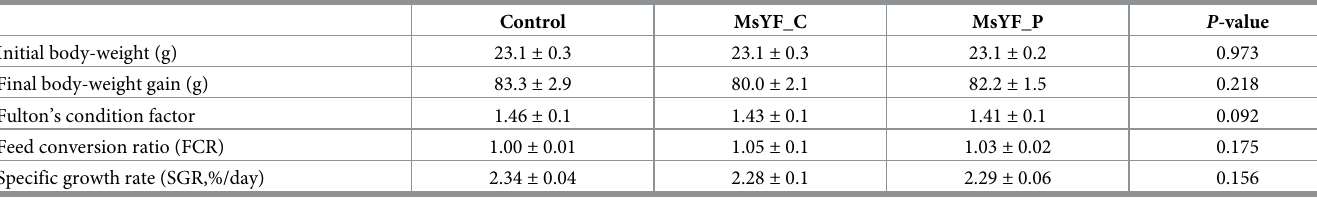
Table 3. Growth performance of rainbow trout over the 8-week trial’s duration (n = 3 tanks/